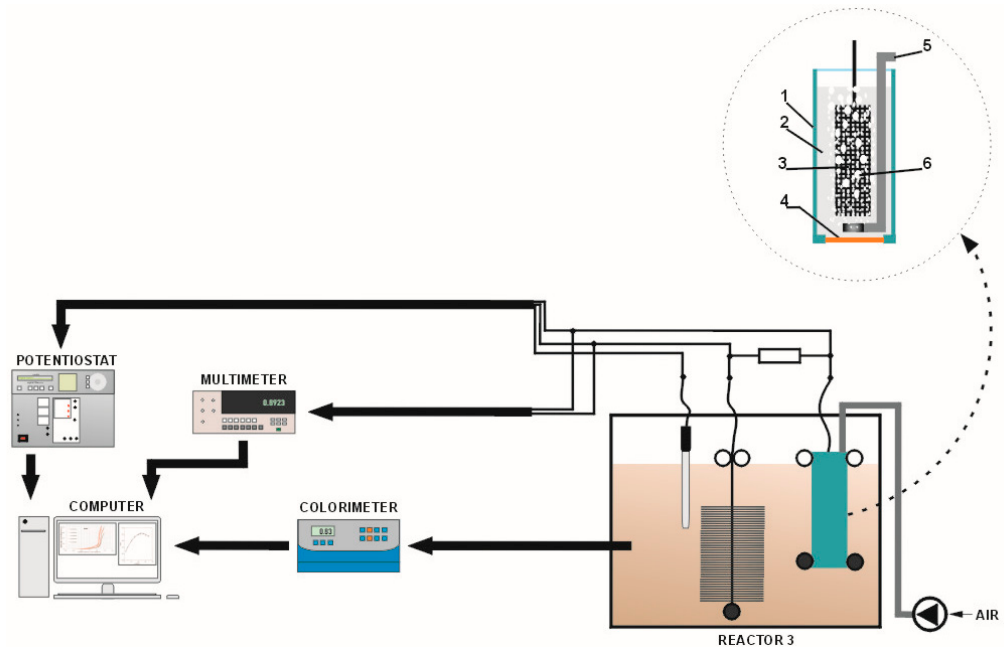
Figure 17. Schematic view of the MFC (Reactor 3, Figure 16): 1, casing; 2, electrolyte; 3, Cu–B cathode or the carbon cloth electrode; 4, proton exchange membrane (PEM); 5, air supply; 6, air bubbles.